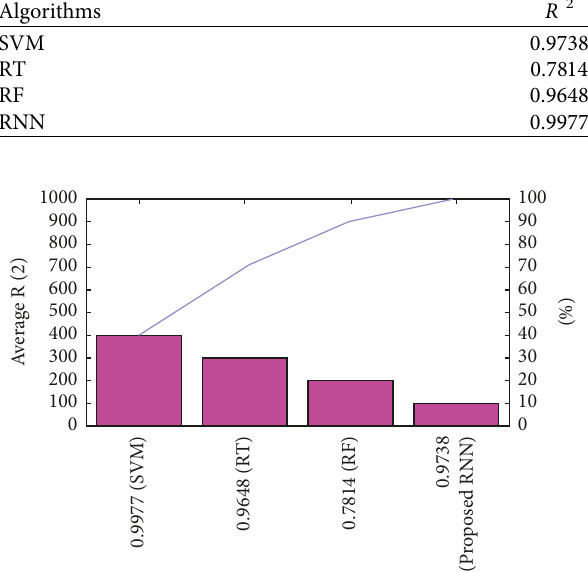
Figure 10: Comparison of R 2 for the selected algorithms.